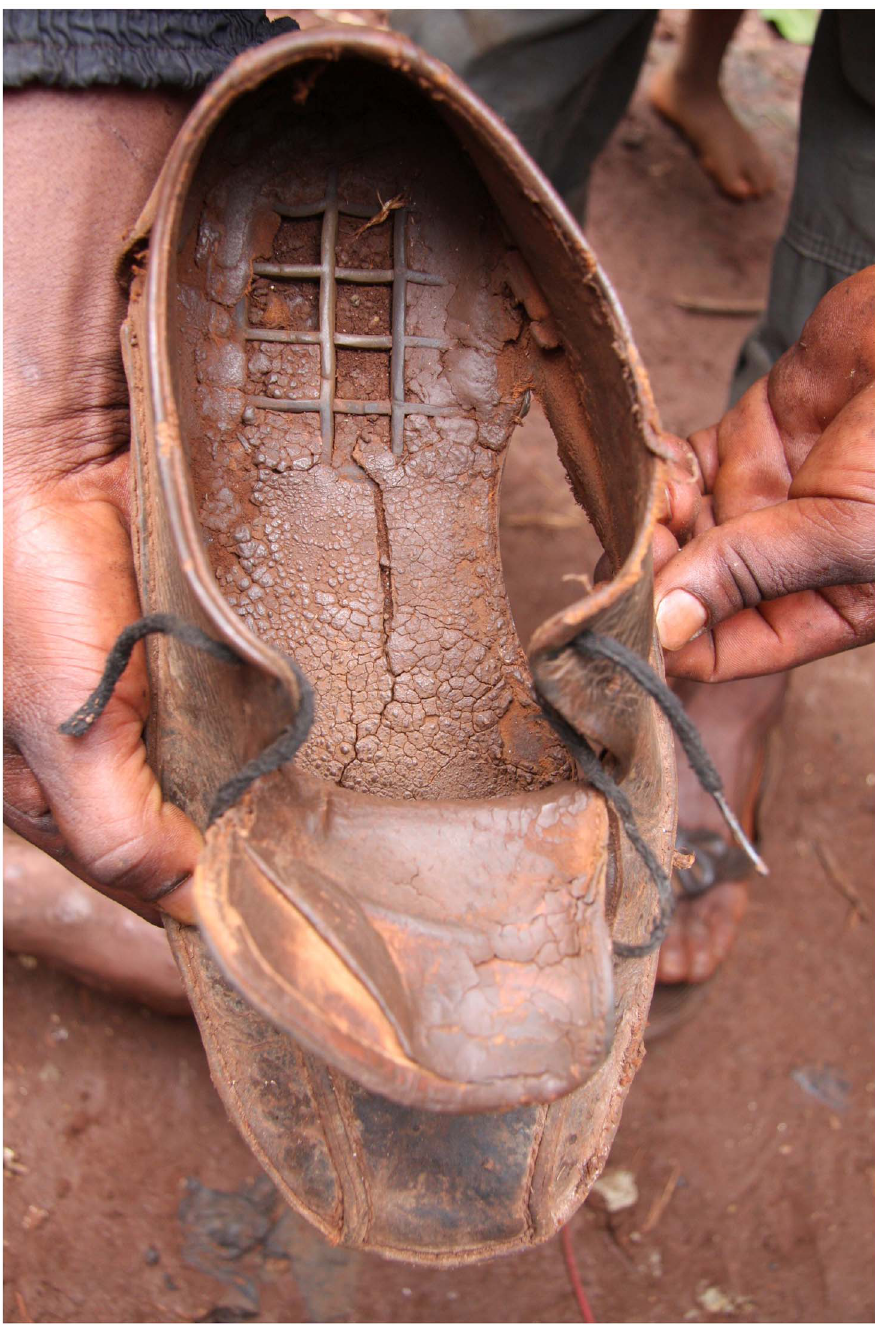
Figure 3. Shoe of an adolescent from rural Kenya after 6 months of use.